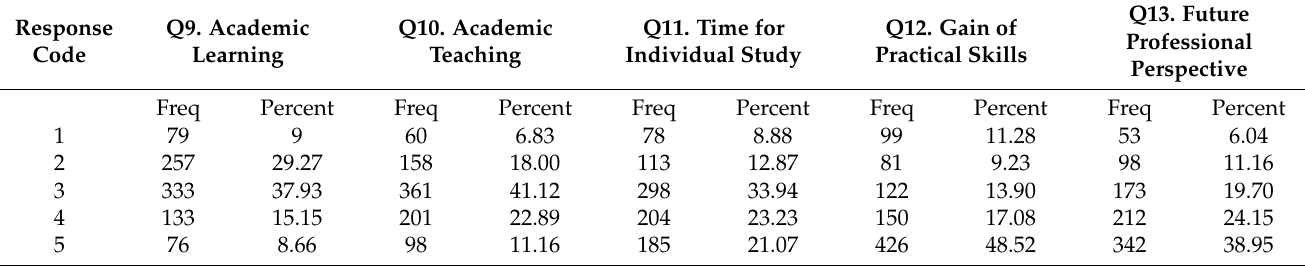
Table 3. Data distribution by responses codes for educational impact